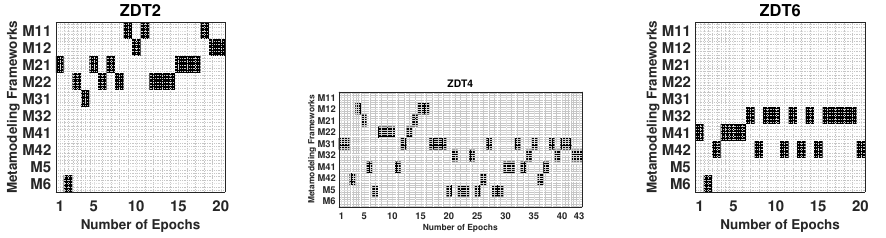
Figure 9. Switching among frameworks for the median IGD run of the ASM approach for ZDT2, ZDT4, and ZDT6 indicates that many frameworks are used during the optimization